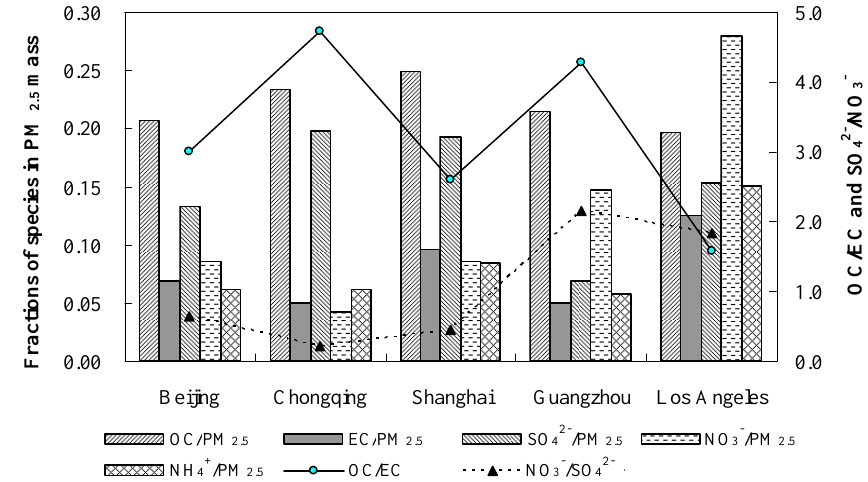
Fig. 2. Relative abundances of five major species in PM 2 . 5 and mass ratios of OC-EC and nitrate-sulfate in four Chinese mage cities. Those in Los Angeles are plotted for